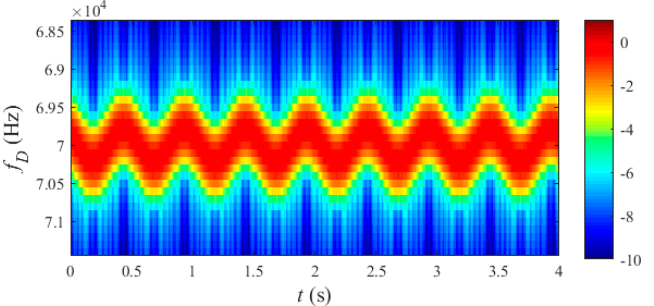
Figure 2. Time − frequency diagram of microwave micro − Doppler echo signal of cube target. Table 2. Cube target laser micro-Doppler signal STFT simulation parameters.